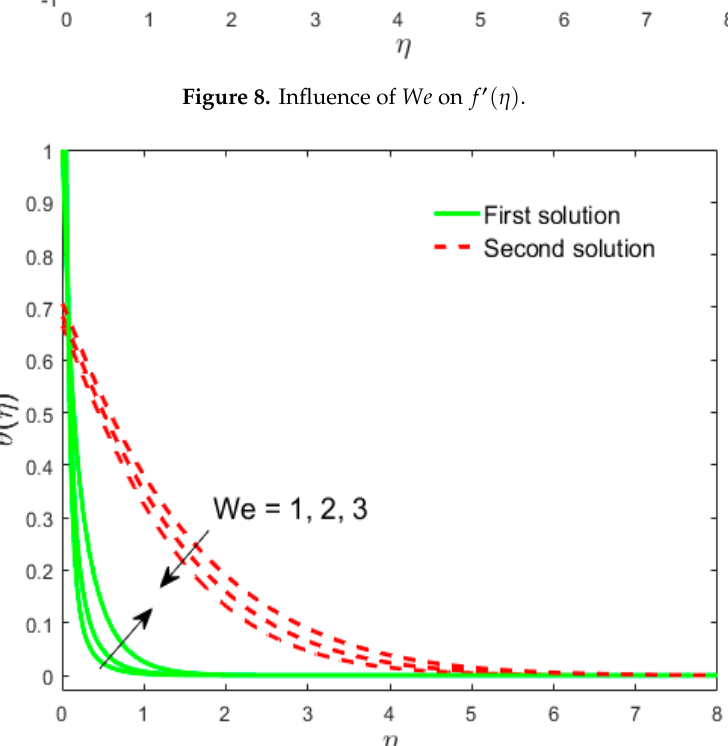
Figure 9. Influence of We on θ ( η )